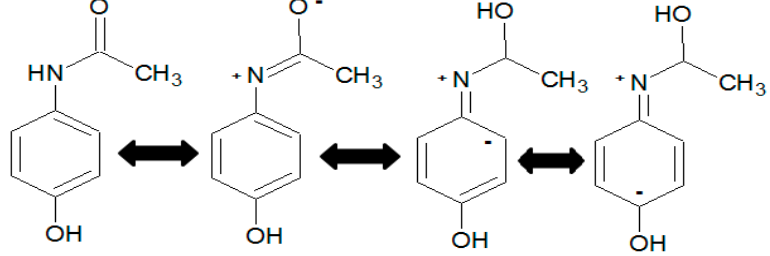
Figure 2. Resonance structures in a paracetamol molecule.